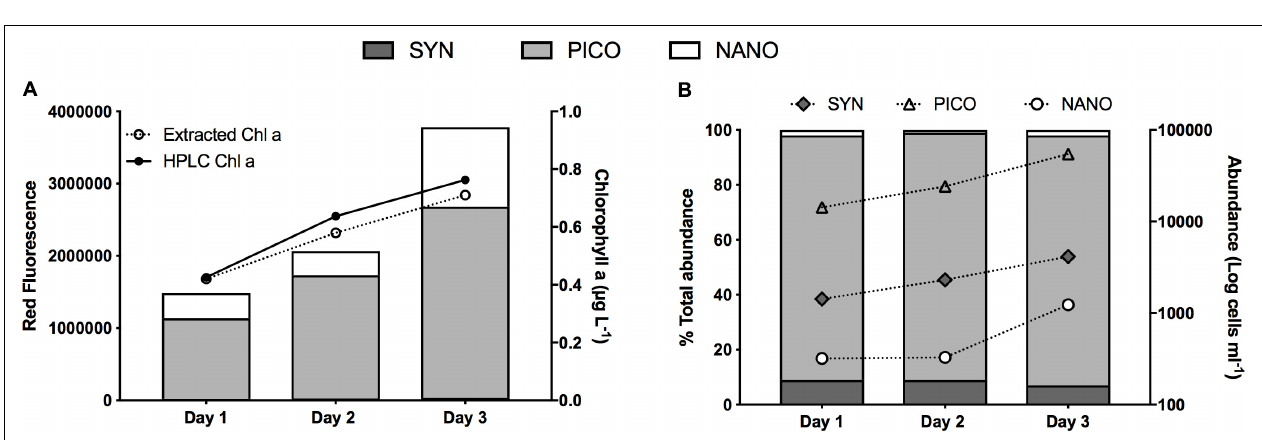
FIGURE 1 | Evolution of mixed layer depth (m) based on density gradient (clear diamond symbols) and fluorescence threshold (BioMLD, solid dots). See section “Materials and Methods” for description of estimates.